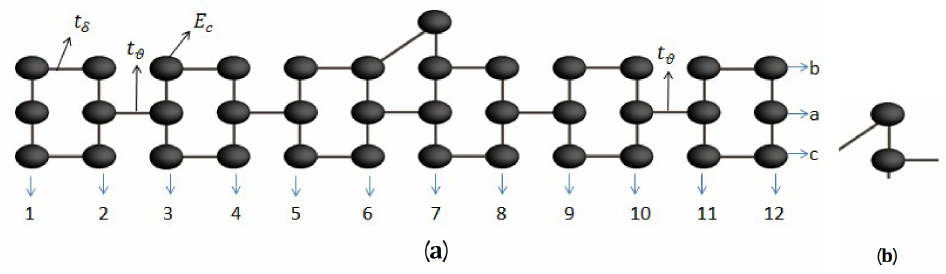
Figure A1. ( a ) Geometric model of the 2,7-Di([1,1 (cid:48) -biphenyl]-4-yl)-9H-fluorene molecule without contacts and ( b ) triangular